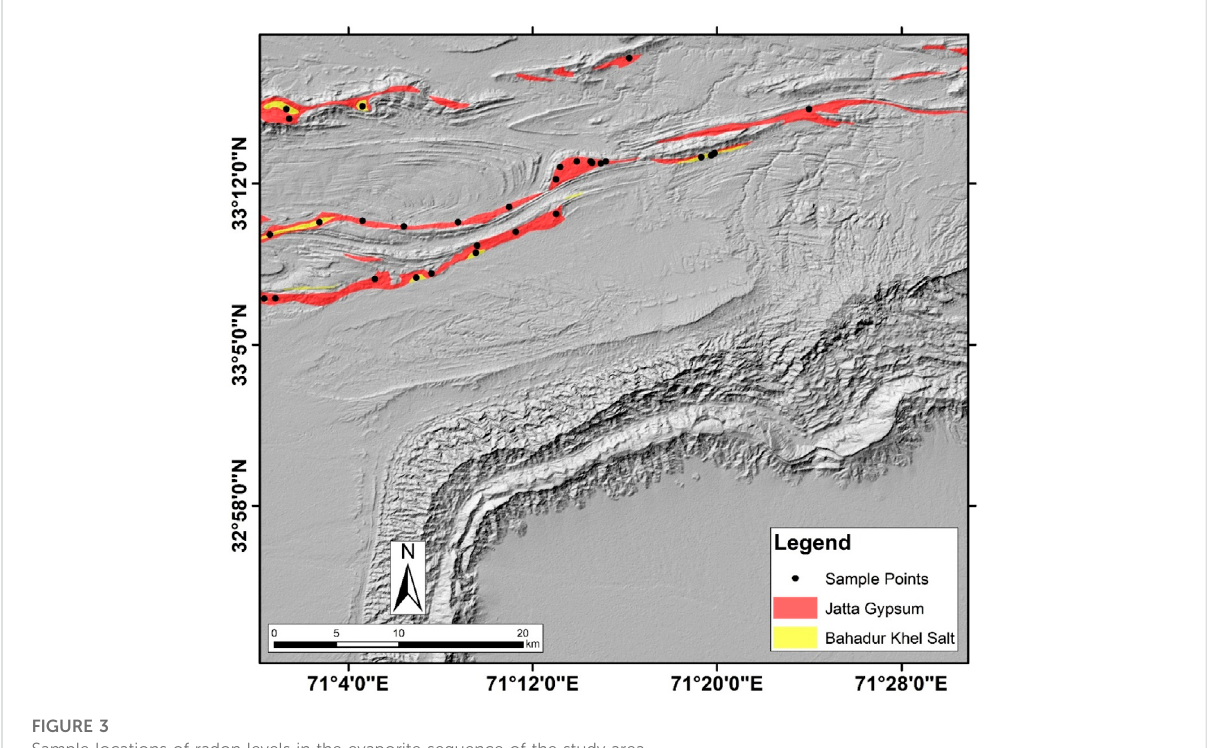
FIGURE 3 Sample locations of radon levels in the evaporite sequence of the study area.